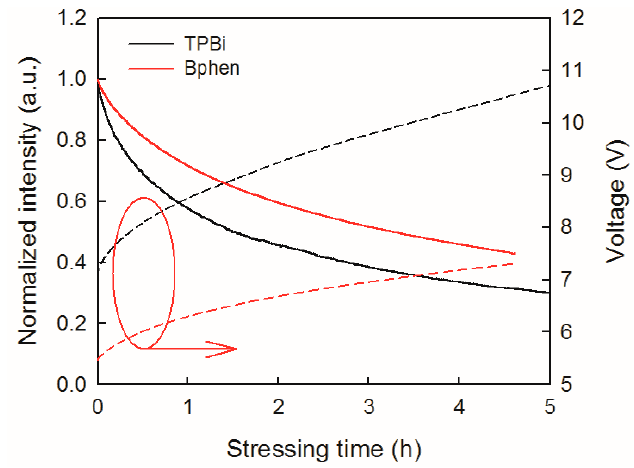
Figure 5. Evolution of the normalized luminance and voltage of blue OLEDs with Bphen and TPBi ETL stressed under 20 mA/cm 2 .